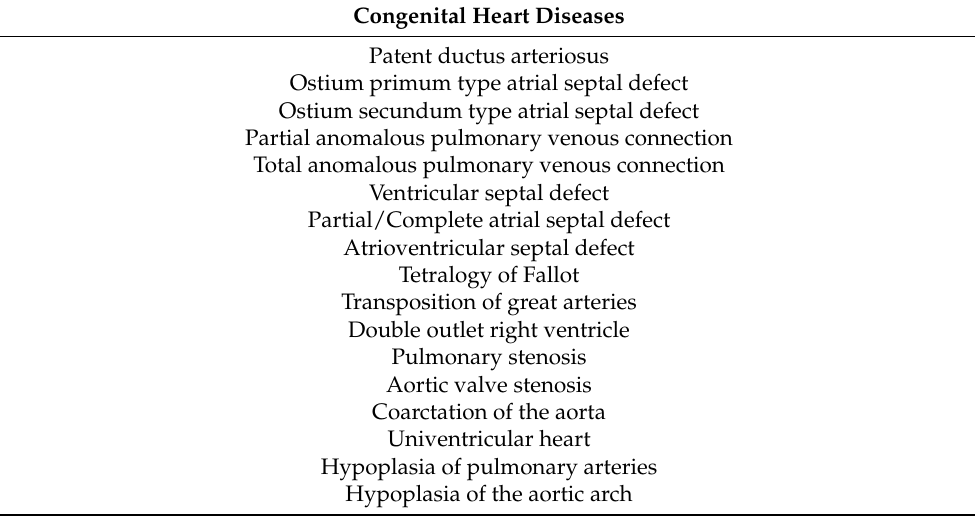
Table 1. Major congenital heart